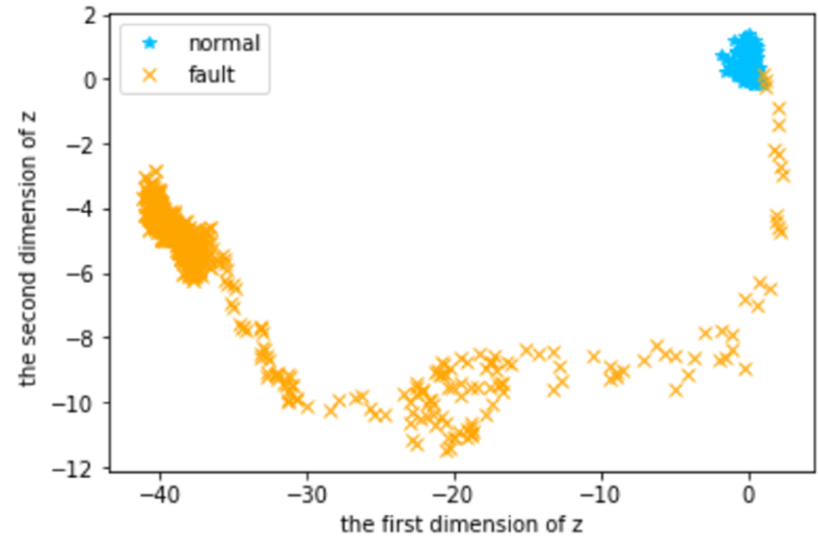
Figure 12. The latent vector z of the 1DAAE for fault 1.